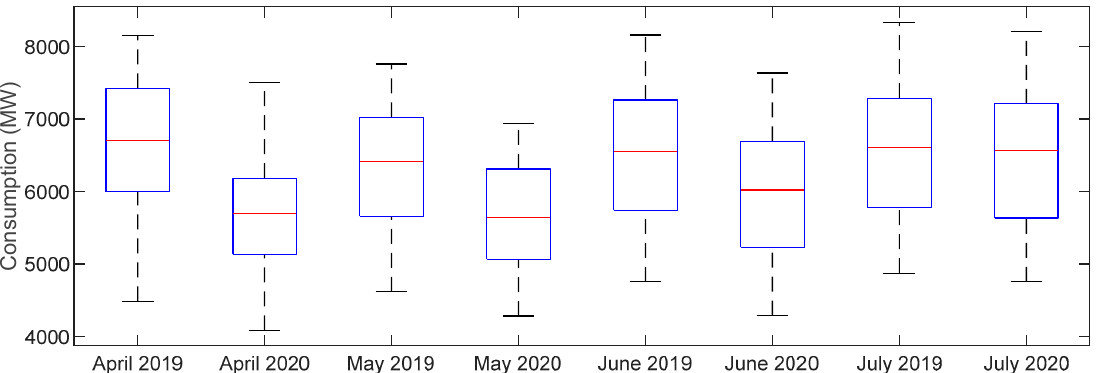
Figure 2. Boxplots of monthly power consumption in the Romanian power system for the April–July period, in 2019 and 2020.